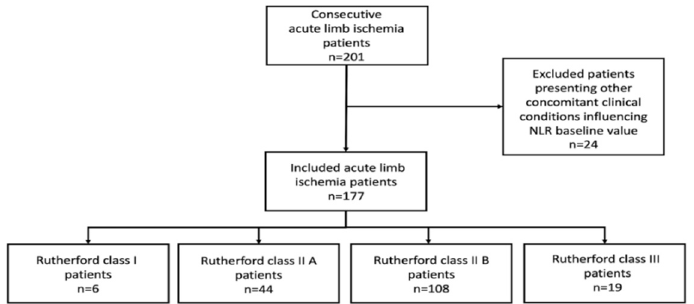
Figure 1. Enrollment flowchart.